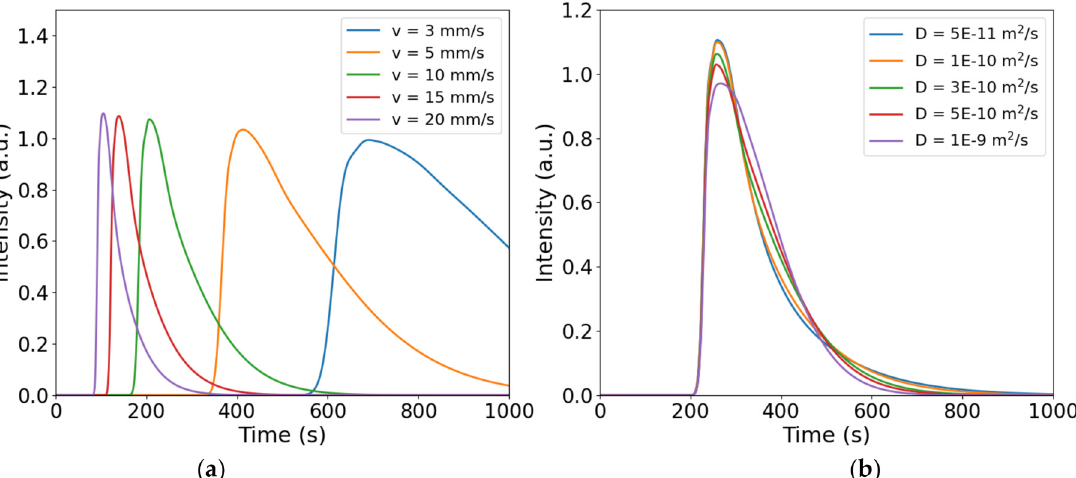
Figure 4. Simulated signals obtained in a channel having radius 1.2 mm and length 30 cm; ( a ) col- ors are associated with different values of flow velocity, while a constant diffusion coefficient of 3 × 10 − 10 m 2 /s is used; ( b ) colors are associated with different values of diffusion coefficient, while a constant flow velocity of 8 mm/s is